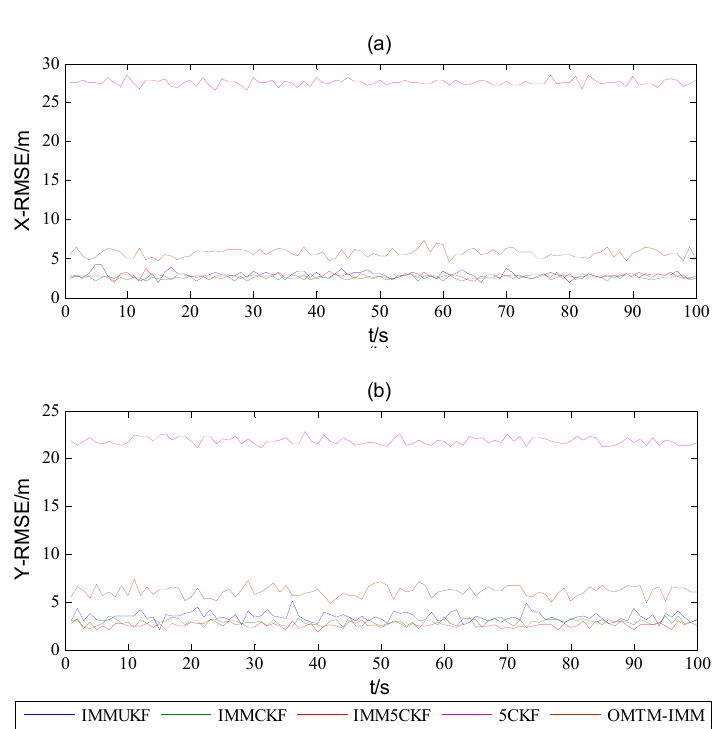
Figure 3. RMSEs of ( a ) X-position and ( b ) Y-position.